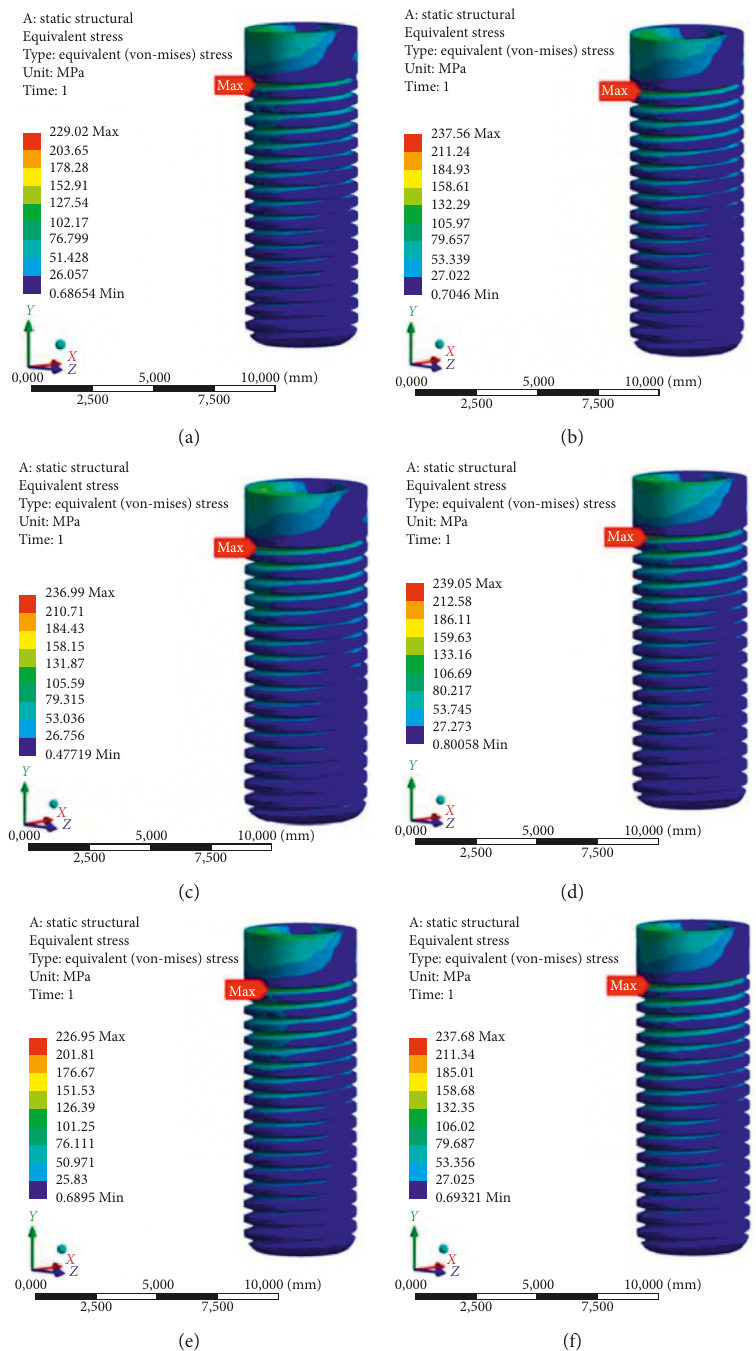
Figure 3: FEA results of implants. Implant materials are AISI 316L stainless steel (a), nanoporous anodic alumina (b), L-605 CoCr alloy (c), cp Ti with the nanotubular TiO 2 surface (d), YSZ (e), and ZTA